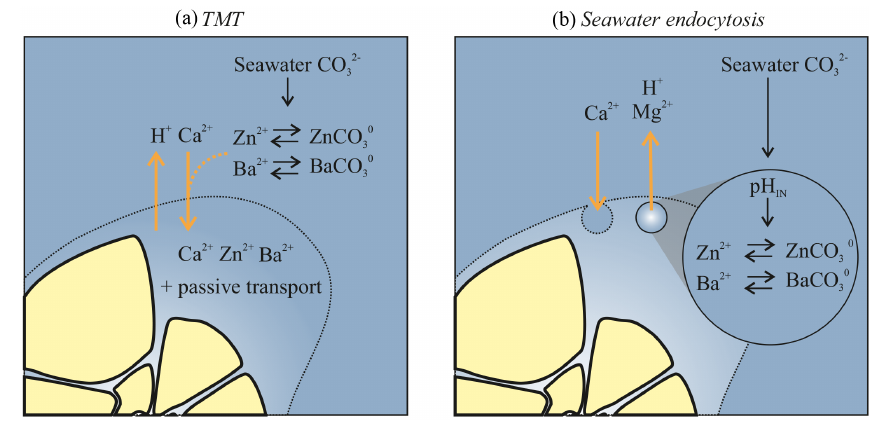
Figure 6. Schematic overview of different mechanisms for ion transport during foraminiferal calcification. Orange arrows indicate transport of ions. (a) The transmembrane transport (TMT) mixing model as proposed by Nehrke et al. (2013). The amount of free ions, e.g., Zn 2 + and Ba 2 + , available for transport by Ca 2 + in exchange for protons (Toyofuku et al., 2017) is influenced by speciation due to changes in seawater [CO 2 − ]. The composition of the seawater at the site of calcification is determined by both TMT and passive transport. (b) Simplified 3 overview of seawater endocytosis (Bentov et al., 2009; Erez, 2003), where speciation of Zn 2 + and Ba 2 + is determined by changes in internal pH (pH IN ) , which changes with ambient seawater carbonate chemistry. Based on our observations, panel (a) likely applies to hyaline species, whereas panel (b) represents porcelaneous